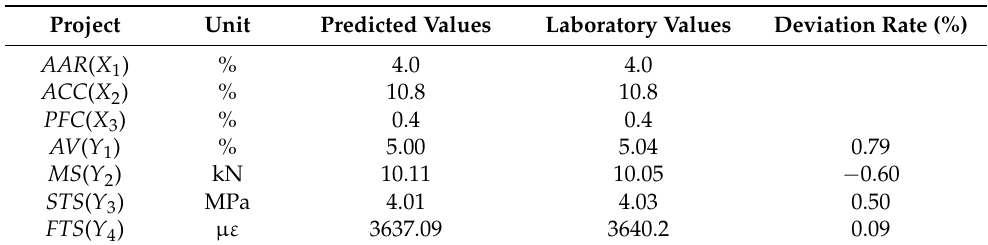
Table 11. Validation laboratory results.